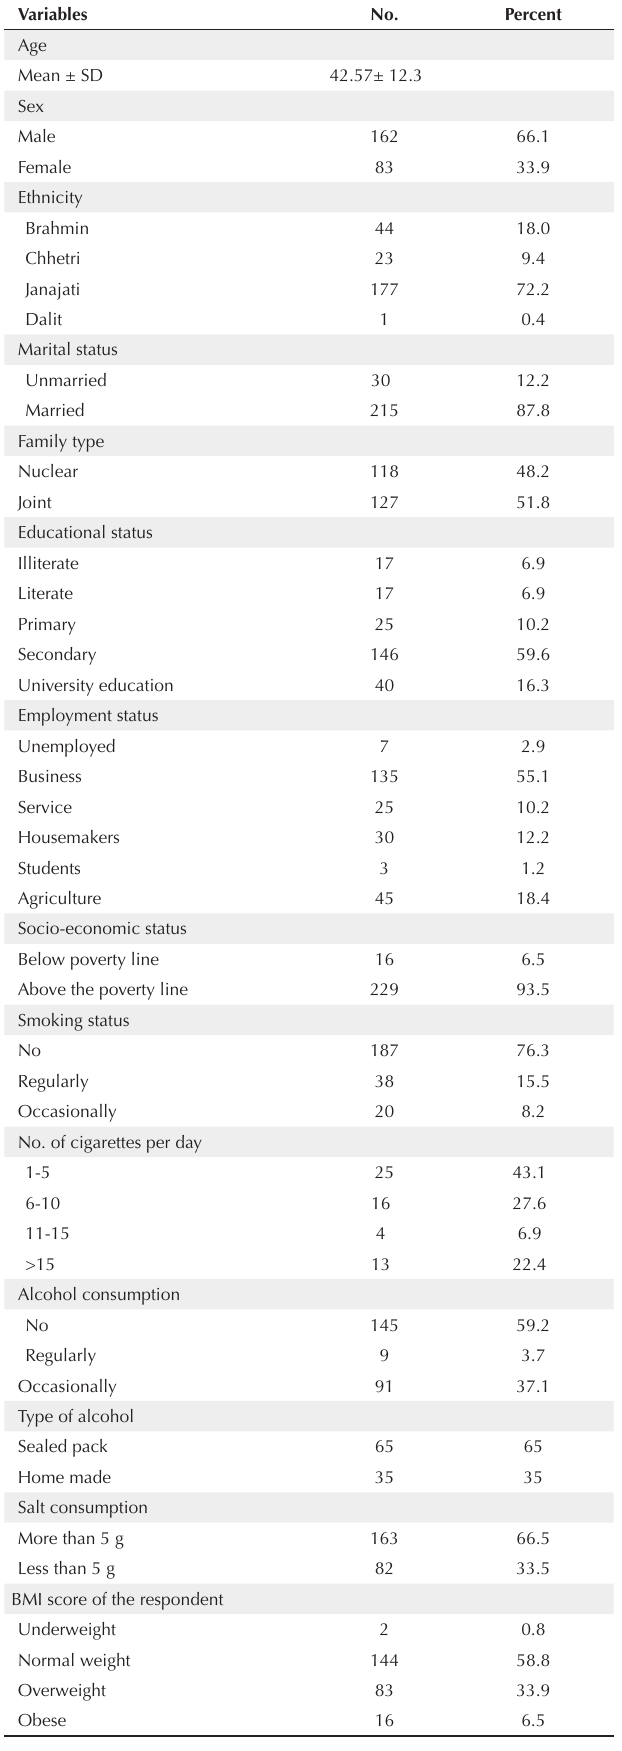
Table 1 . Demographic characteristics of the respondents (n = 245) Table 2. Indian Diabetes Risk Score (IDRS) of the respondents